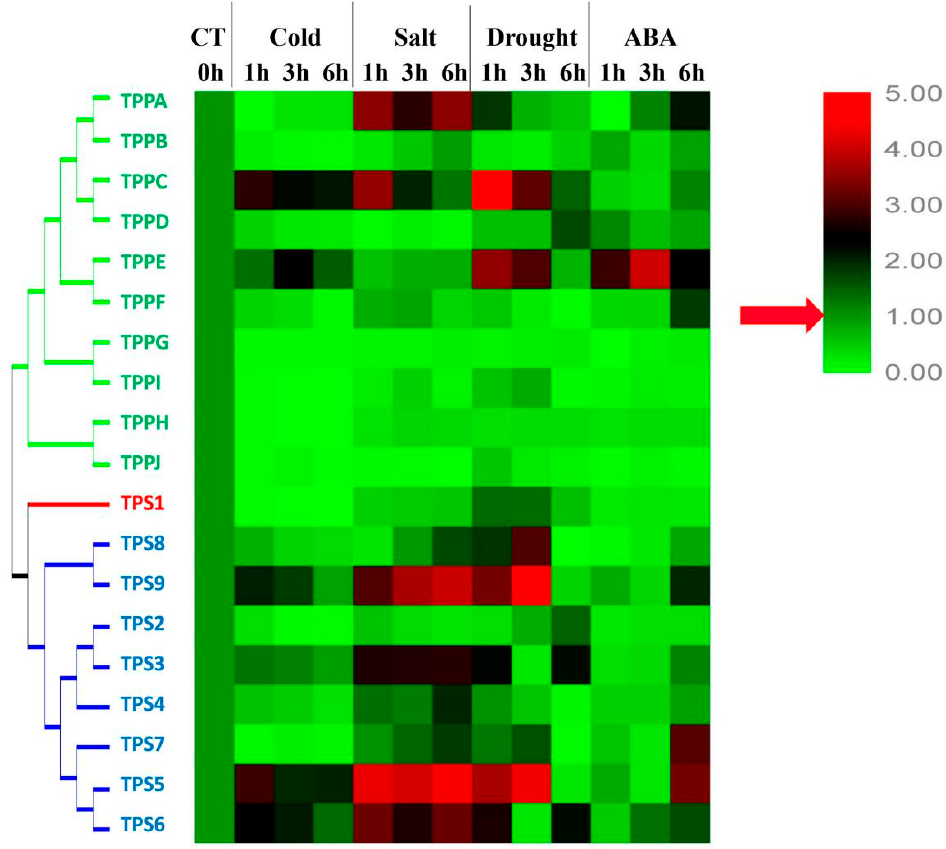
Figure 9. Expression patterns of BdTPS and BdTPP genes under three different abiotic stresses and abscisic acid (ABA) treatment in the whole plants. The gradient ramp represents different relative expression levels. The green indicates a low expression level and the red indicates a high expression level.